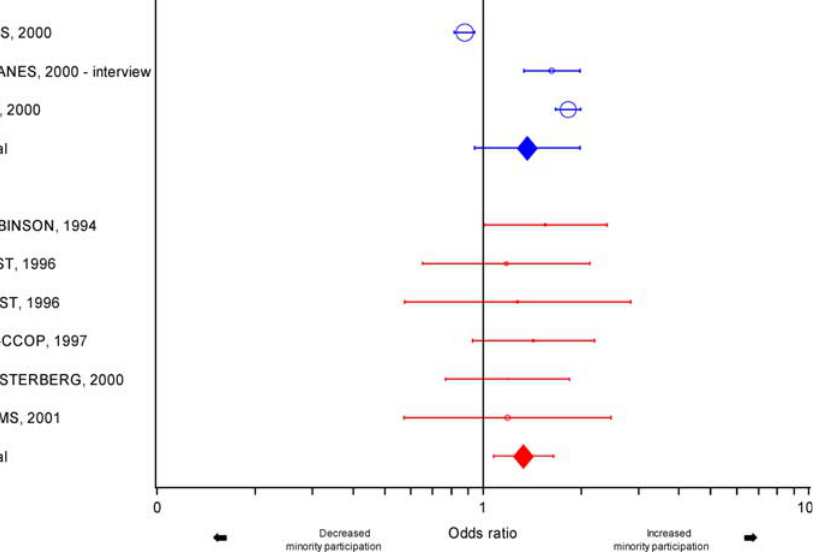
Figure 3. Comparison of Hispanic versus non-Hispanic White Consent Rates Circle diameter is proportional to the sample size of the individual studies. The diamond represents the overall OR. The vertical line indicates the 95% confidence interval on the OR. Blue indicates interview and non-intervention studies; red indicates clinical intervention studies. DOI: